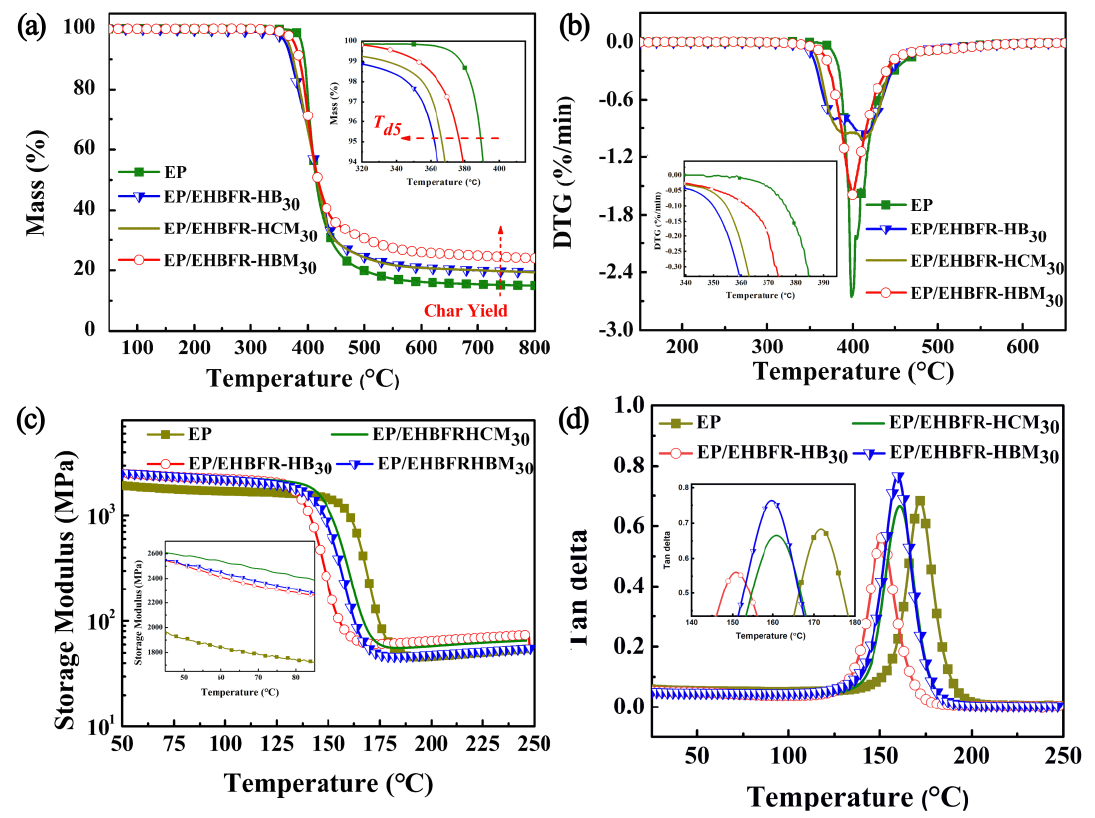
Figure 4. Non-isothermal TGA and DTG curves ( a , b ) for cured EP/EHBFR30; variation of storage modulus with temperature for cured EP/ EHBFR 30 ( c ); and T g of cured EP/ EHBFR 30 (d).